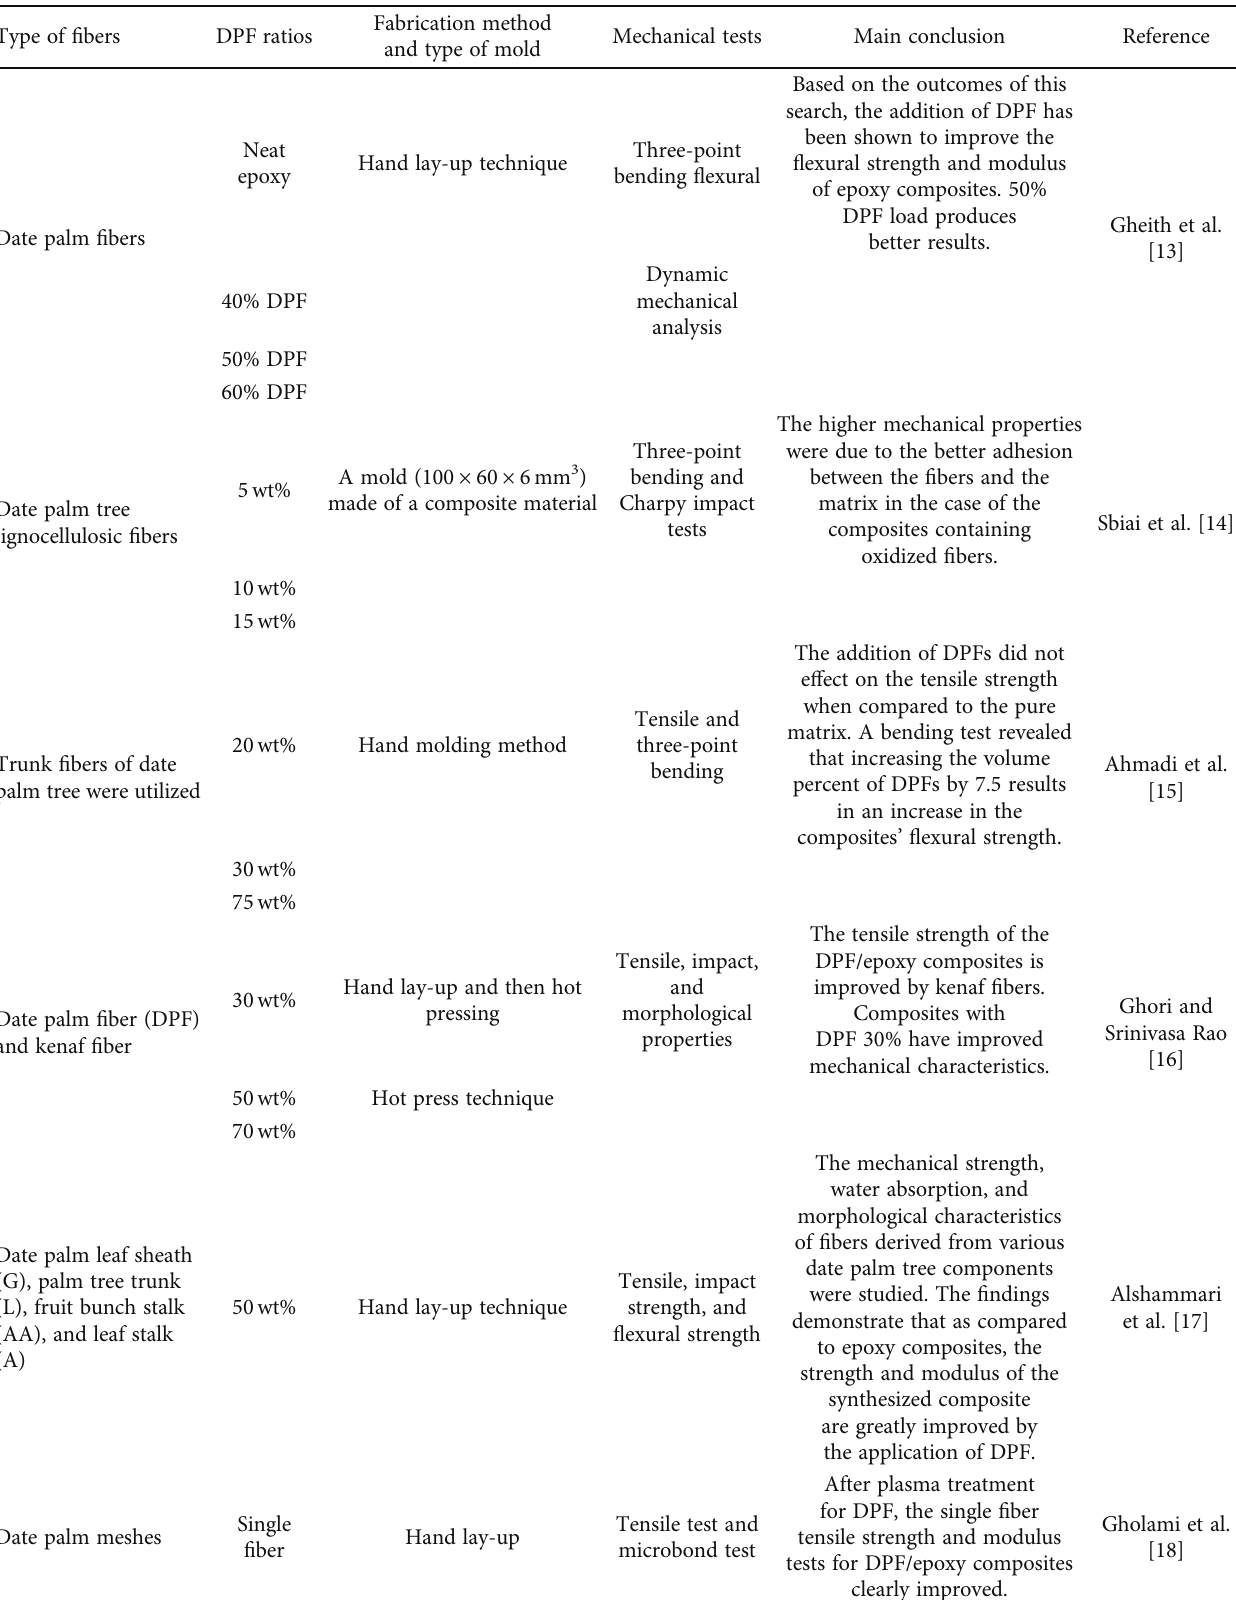
Table 1: Research studies on epoxy – DPF